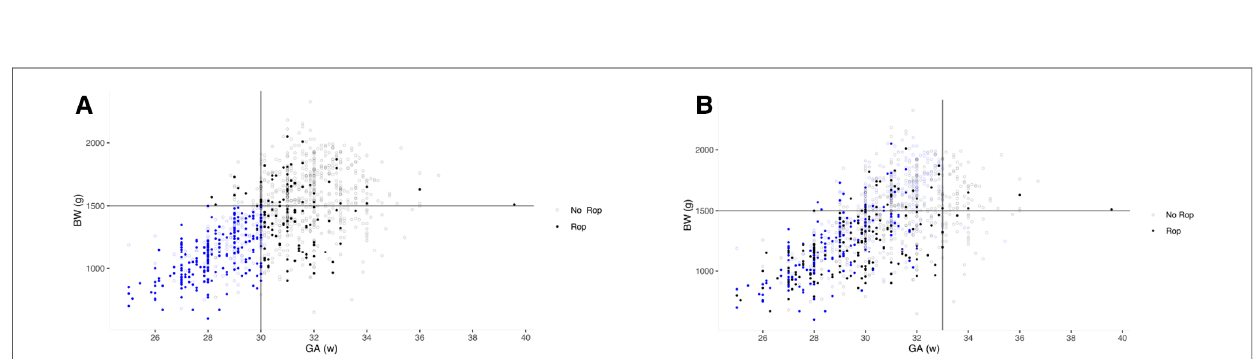
FIGURE 3 Two scatter plots based on gestational age (GA) and birth weight (BW) of infants in two populations. Empty circle means infants with any ROP, and fi lled circle means infants without any ROP. Circles color-coded by blue were infants included by each model. The lines de fi ne the thresholds for BW and GA in different models. ( A ) Co-ROP for any ROP; ( B ) Alex-ROP for any